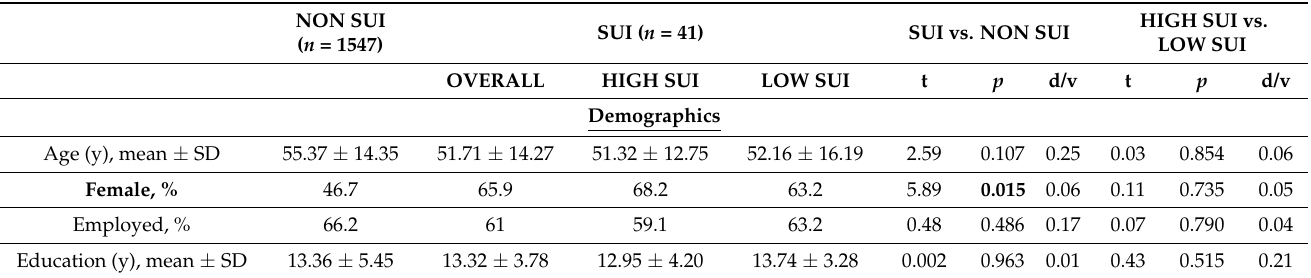
Table 2. Demographic and clinical characteristics of subjects with SUI, NON SUI, LOW SUI, and HIGH